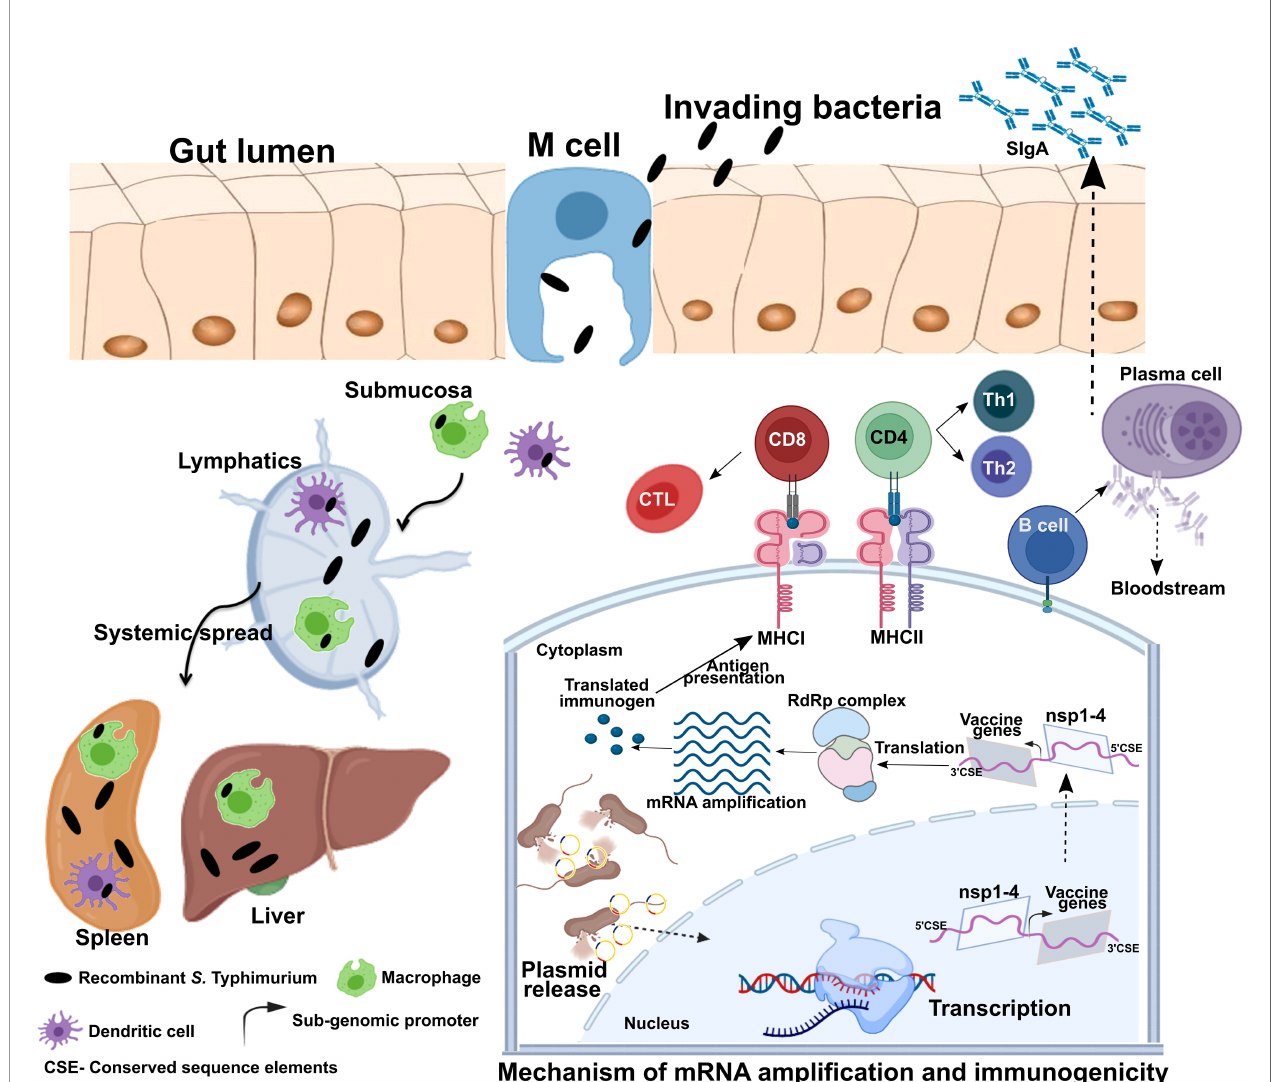
FIGURE 2 | Mechanism of gene delivery, transgene expression, and induction of immune response. Upon oral administration, Salmonella Typhimurium is translocated from the luminal surface to submucosa by specialized M cells in the gut epithelium. Bacteria then invade antigen-presenting cells (APCs), such as macrophages and dendritic cells (DCs), and spread to different organs like the liver and spleen through lymphatics and the bloodstream. The vector encoding the Semliki Forest virus (SFV) replicon (nsp1-4) and SARS-CoV-2 immunogens is released within the host cell cytoplasm through bacterial lysis. Transcription of the delivered plasmid takes place in the cell nucleus, and, following in situ translation, the nsp1-4 proteins form an RNA-dependent RNA polymerase (RdRp) complex. The RdRp complex then recognizes the sub-genomic promoter and fl anking conserved sequence elements (CSE), leading to enhanced mRNA ampli fi cation of vaccine genes. The resulting mRNAs translated to produce immunogenic proteins. The APCs process and present antigens to CD8+ and CD4+ T cells via MHC I and MHC II, respectively, leading to the elicitation of the T cell response. DCs can present antigens directly to B cells or follicular DCs (FDCs). FDC stores antigens for a longer time, periodically displaying them to cognate B cells. B cells then differentiate to speci fi c antibody-secreting plasma cells and memory B cells. MHC, major histocompatibility complex; nsp, non-structural protein; CD, cluster of differentiation; CTL, cytotoxic T cell; Th, T helper cell; CSE- Conserved sequence elements. This fi gure was created with the help of the Biorender online tool (https://app.biorender.com/). The fi gure and description are reproduced with permission from Jawalagatti et al., 2022 (reference 82). ©The American Society of Gene and Cell